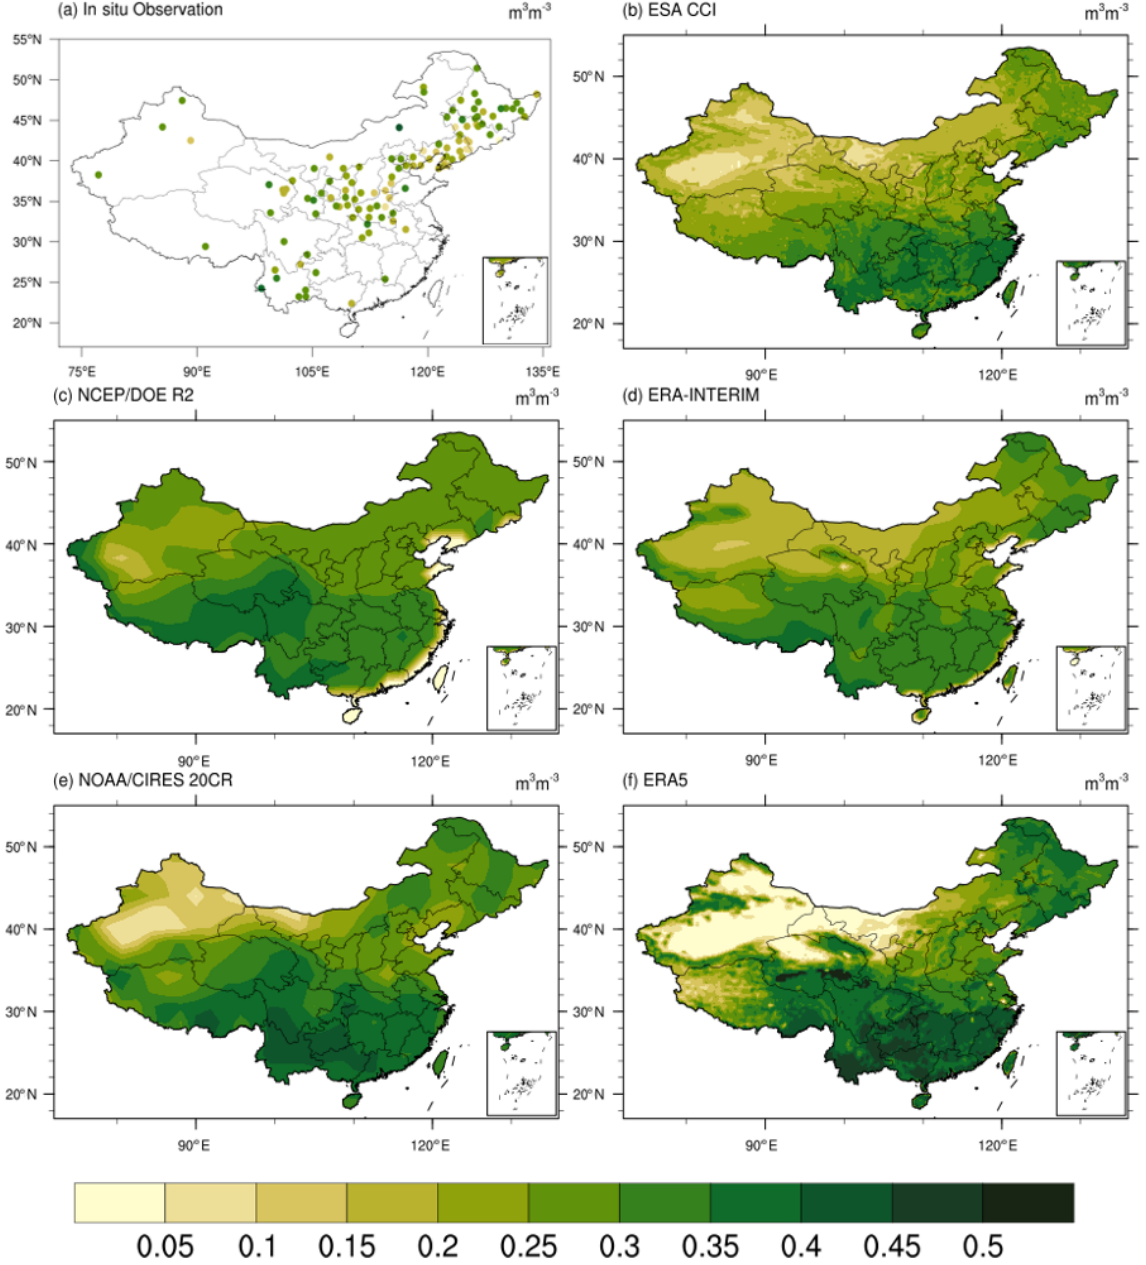
Figure 2. Annual averages of (a) observations and (b–e) five satellite and reanalysis SM products (m 3 m − 3 ) during JJA for the period of 1981 to 2013 in